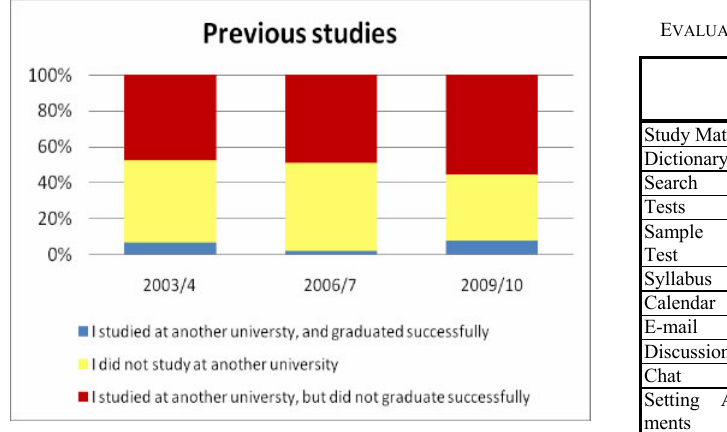
Figure 3. Respondents´ previous studies